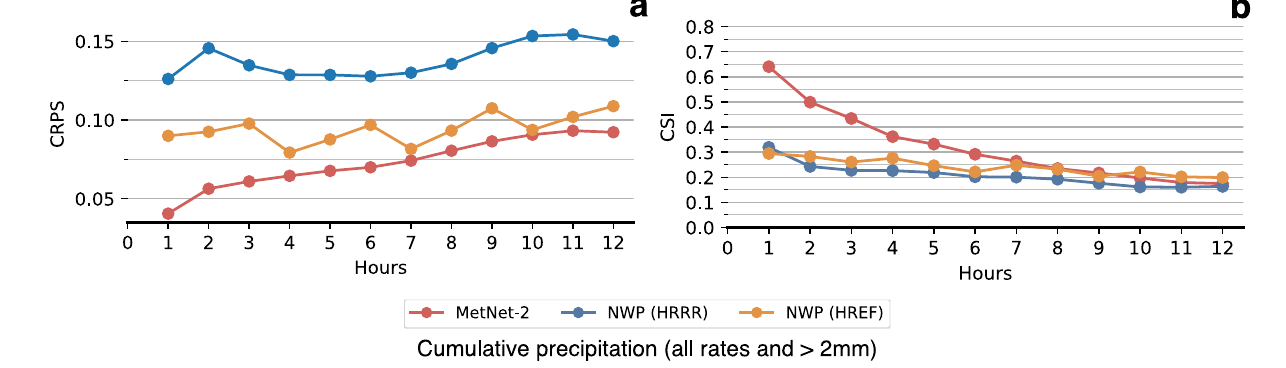
Fig. 2 | Evaluation of the models ’ performance (dataset A). Performance com- parison on test dataset A between the probabilistic MetNet-2 and HREF. Non- probabilistic HRRR results as reference. a Evaluation based on probabilistic CRPS